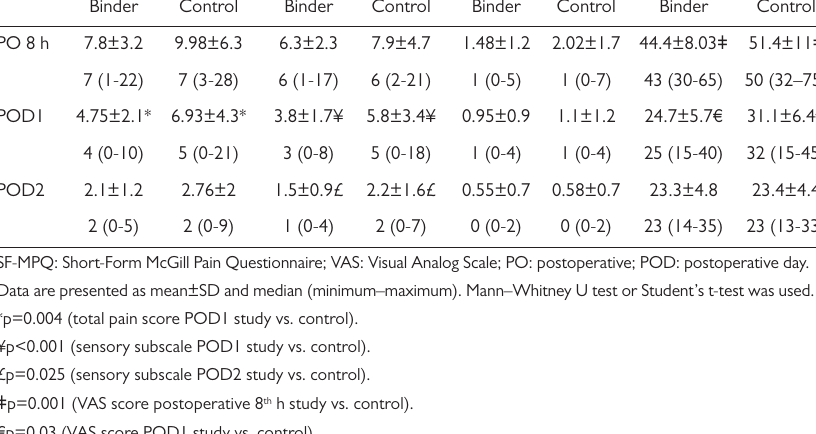
Table 3. SF-MPQ and VAS scores of the study and control groups Total score Sensory Affective